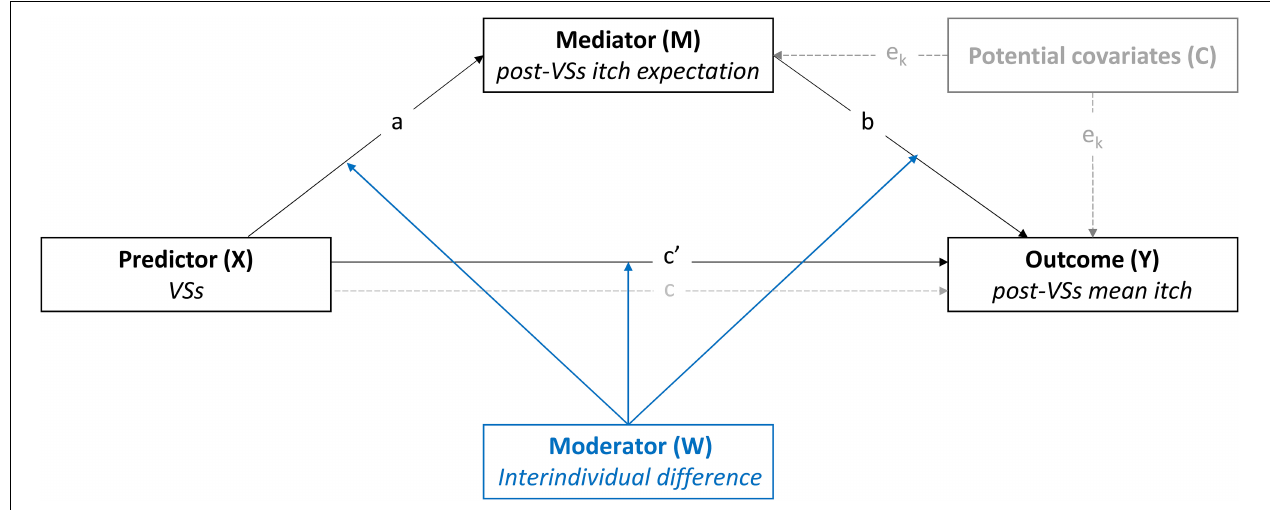
FIGURE 1 | Conceptual representation of the first- and second-stage dual moderated mediation model (model 59, Hayes, 2017). The effects of positive and negative verbal suggestions (VSs) on mean itch during histamine iontophoresis were tested across the three studies. Moderation of the model by interindividual differences was tested on the indirect and direct pathways from VSs to the outcome (mean itch). The model was controlled for Pre-VSs itch expectation (studies 1–3) and baseline itch (studies 2–3). A representation of the statistical model including the tested interactions can be found in the Supplementary Material